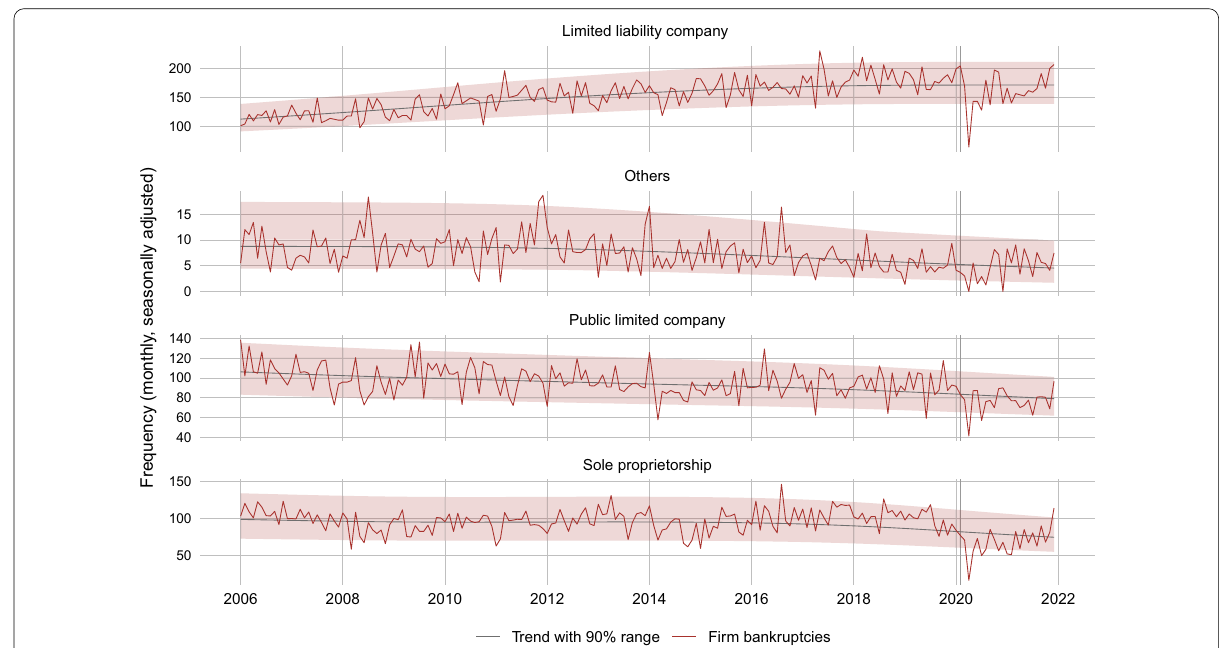
Fig. 19 Firm bankruptcies by legal form. Notes : The figure shows the monthly seasonally adjusted frequency of total firm bankrupcties in Switzerland excluding SCO Art. 731b cases dissagragated by the legal form of the firms